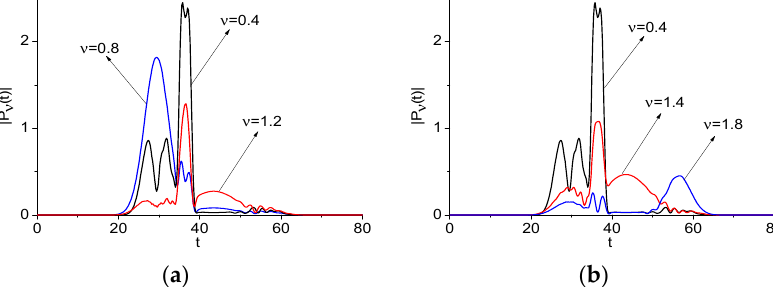
Figure 4. Evolution of the spectral amplitude modulus at the di ff erence frequency ν dif = 0.4 (black line, signal ( t ) ) and basic one ν base = (0.8, 1.2) ( a ), and (1.8, 1.4) ( b ) (blue and red lines, signal E inc ( t ) ), respectively.